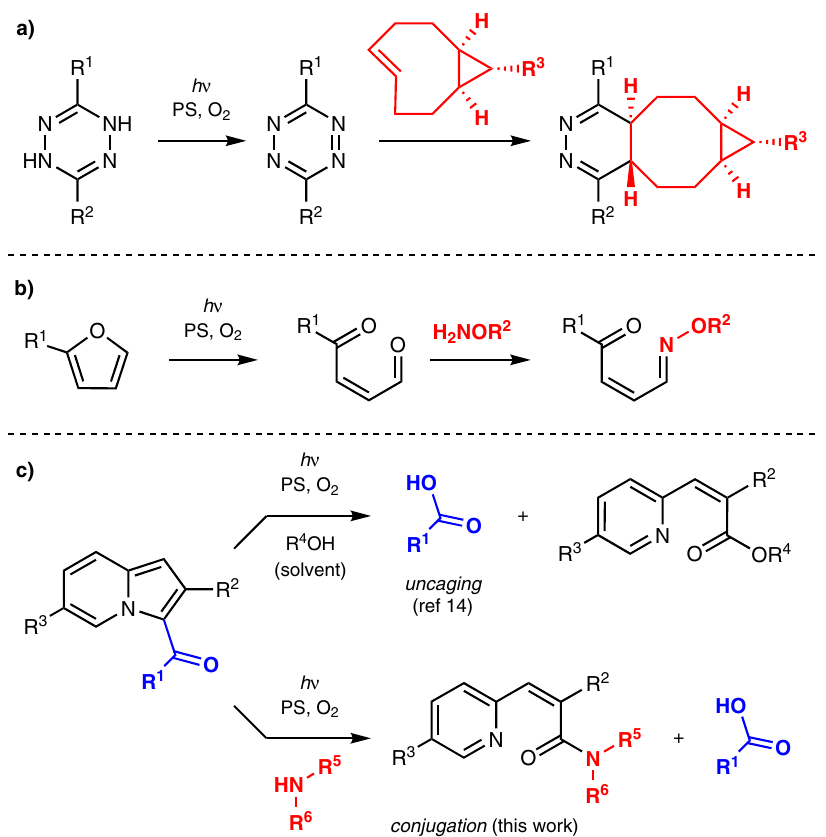
Fig. 1 Photooxidation-initiated conjugation. a Inverse-electron-demand Diels – Alder reaction initiated via tetrazine formation. b Oxime ligation reaction via aldehyde formation. c This work: amide formation via photooxidative ring-opening of indolizines. PS